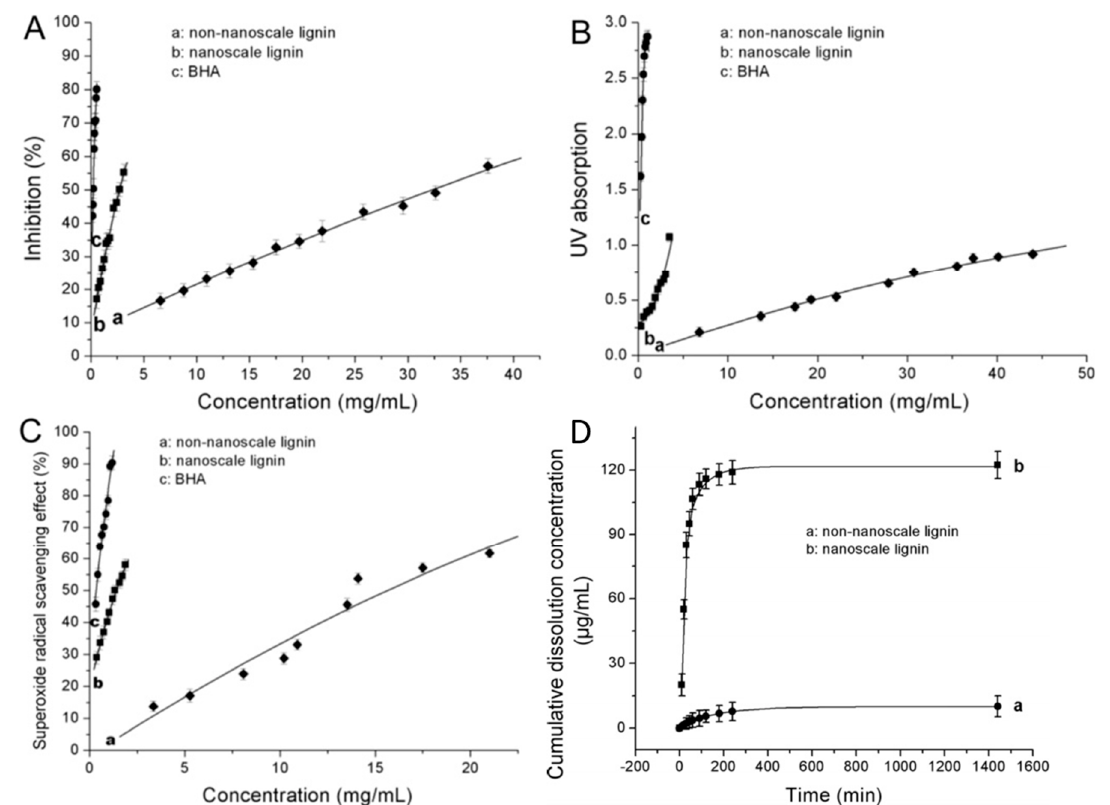
Figure 5. ( A ) 2,2-diphenyl-1-picrylhydrazyl (DPPH) radical-scavenging capacity; ( B ) reducing power; ( C ) superoxide radical scavenging activity; and ( D ) Dissolution profiles in water at room temperature of non-nanoscale lignin and nanoscale lignin. The antioxidant butylated hydroxyanisole (BHA) was used as control. Reprinted from [71], with permission from Elsevier.